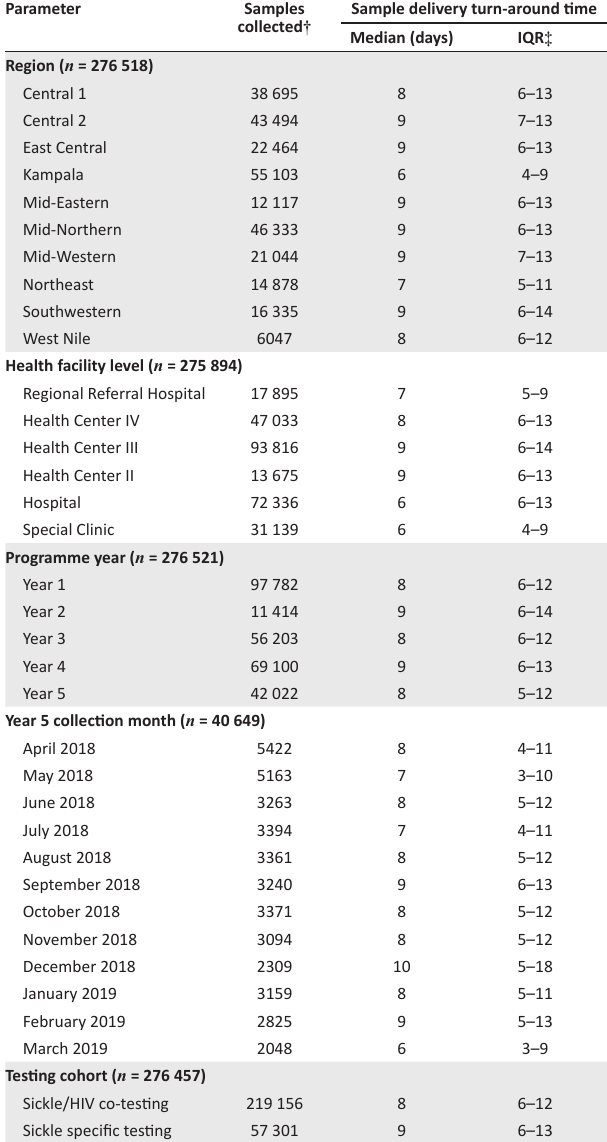
TABLE 2: Sample delivery phase turn-around time for sickle cell samples collected in Uganda, by parameter, February 2014 to March 2019. Parameter Samples collected †